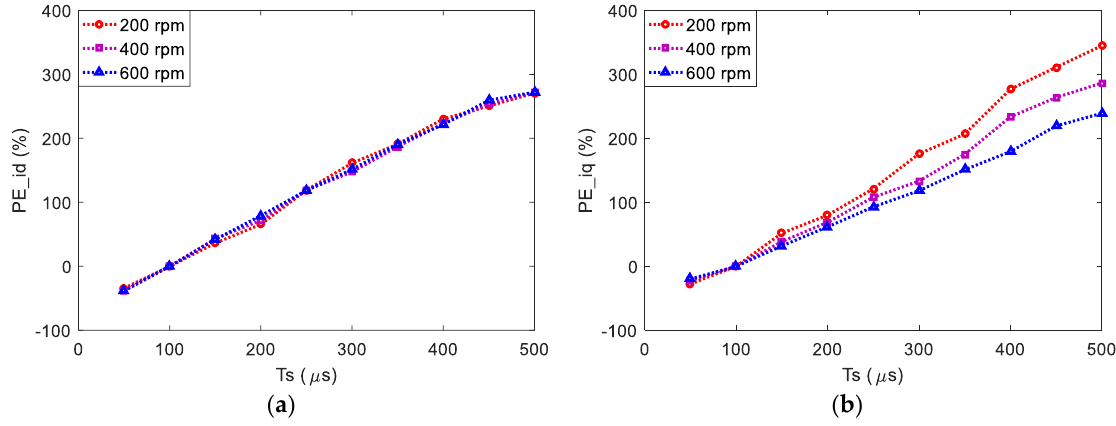
Figure 4. Relative prediction error under different prediction stepsizes. ( a ) Relative prediction error of i d ; ( b ) Relative prediction error of i q .